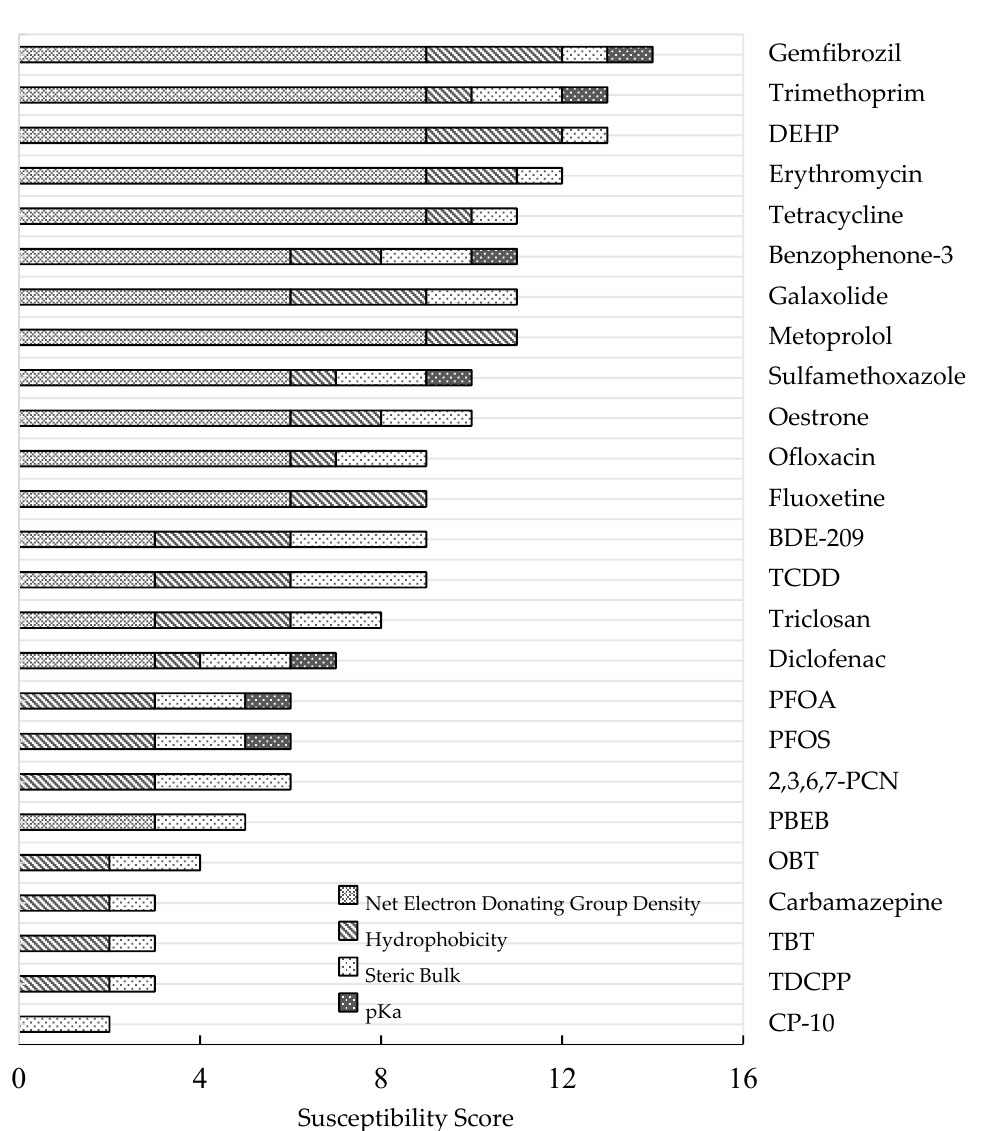
Figure 1. Shortlisted OCs in order of their assessed susceptibility to oxidoreductase degradation. The breakdown of individual criteria scores is represented by patterned bars.